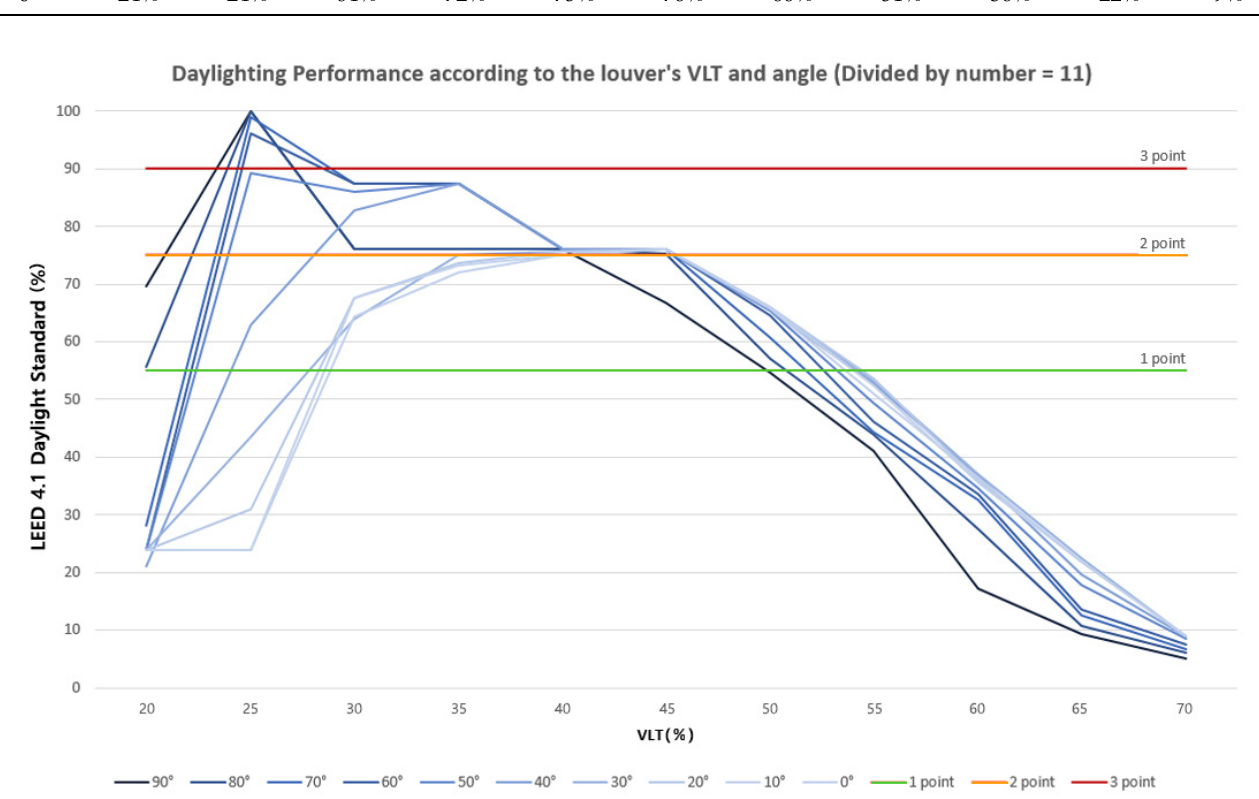
Figure 6. Target illuminance achievement rate graph when the number of divisions of louvers is 11.